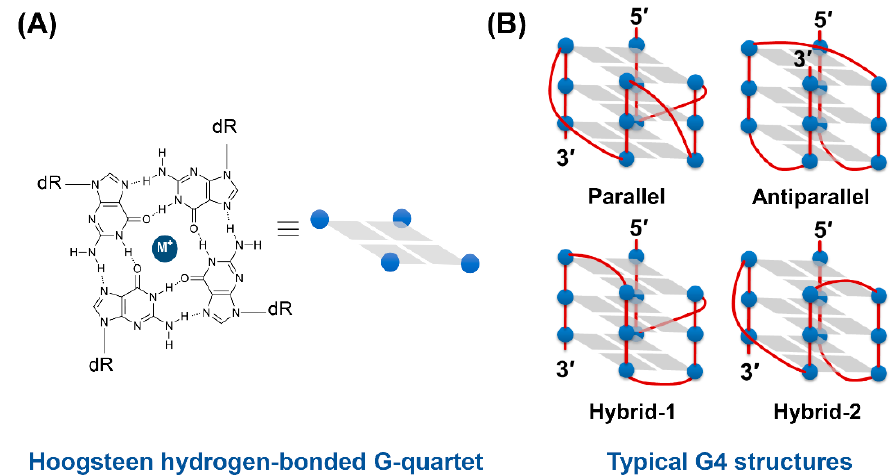
Figure 1. ( A ) Chemical structure of a G-quartet (M + indicates a monovalent cation) and ( B ) illustration of typical G4 structures.